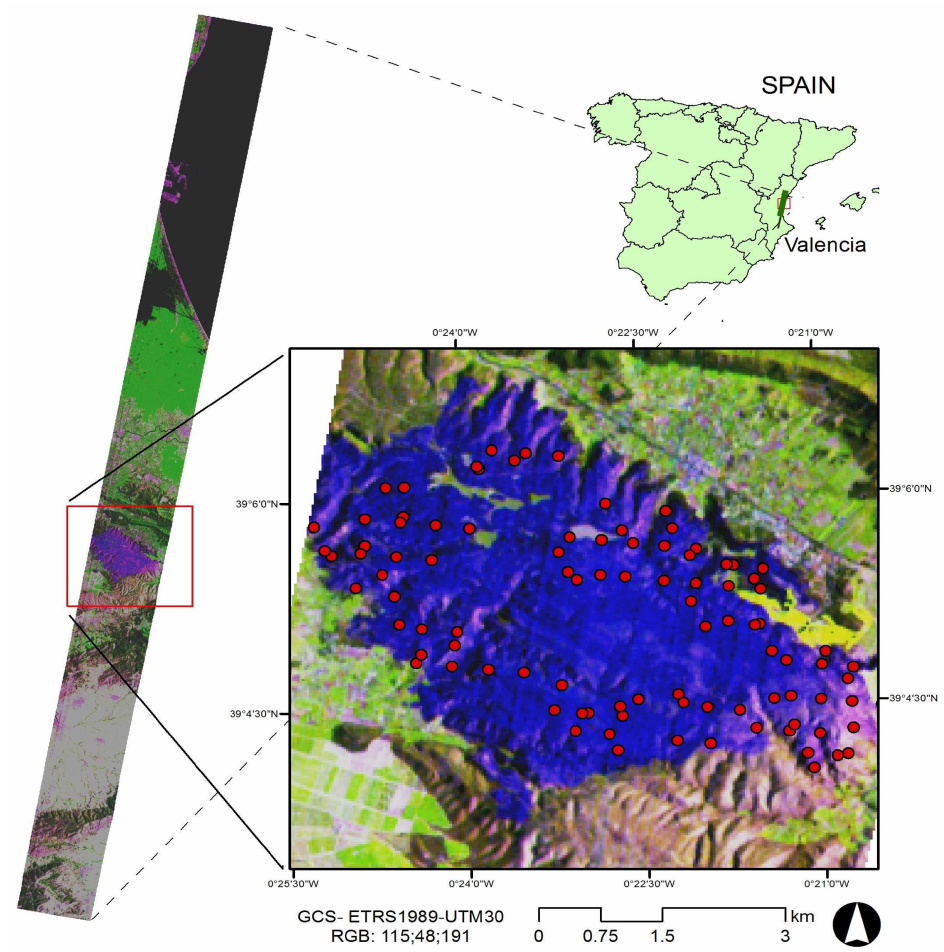
Figure 1. Study area. Earth-Observing One (EO-1) Hyperion color composition (RGB: 115:48:191) and fire hotspots from Visible Infrared Imaging Radiometer Suite Near Real-Time (VIIRS NRT) 375 m active fire